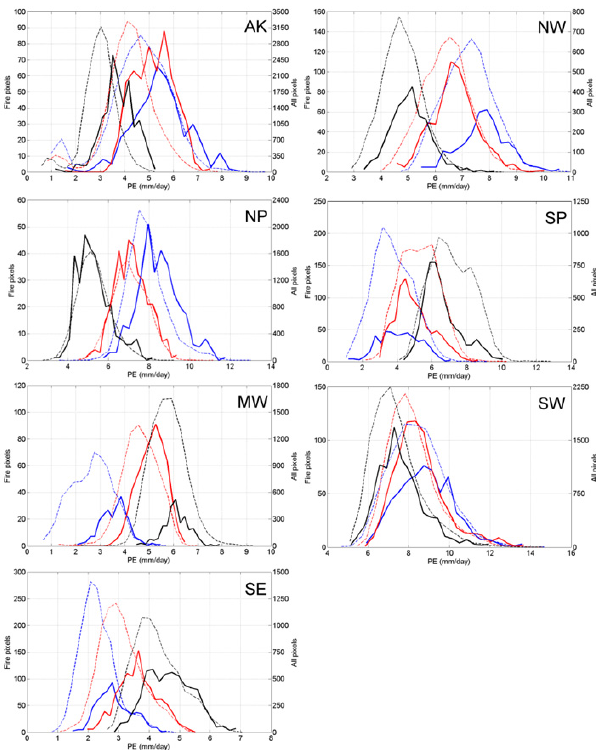
Fig. 10. Histograms of monthly PE (1997–2010) for 0.5 ◦ fire grid cells (solid lines) and all grid cells (dashed lines) by region. Blue, red, and black lines indicate the first, second, and third months of the fire season, respectively (see Table 1).